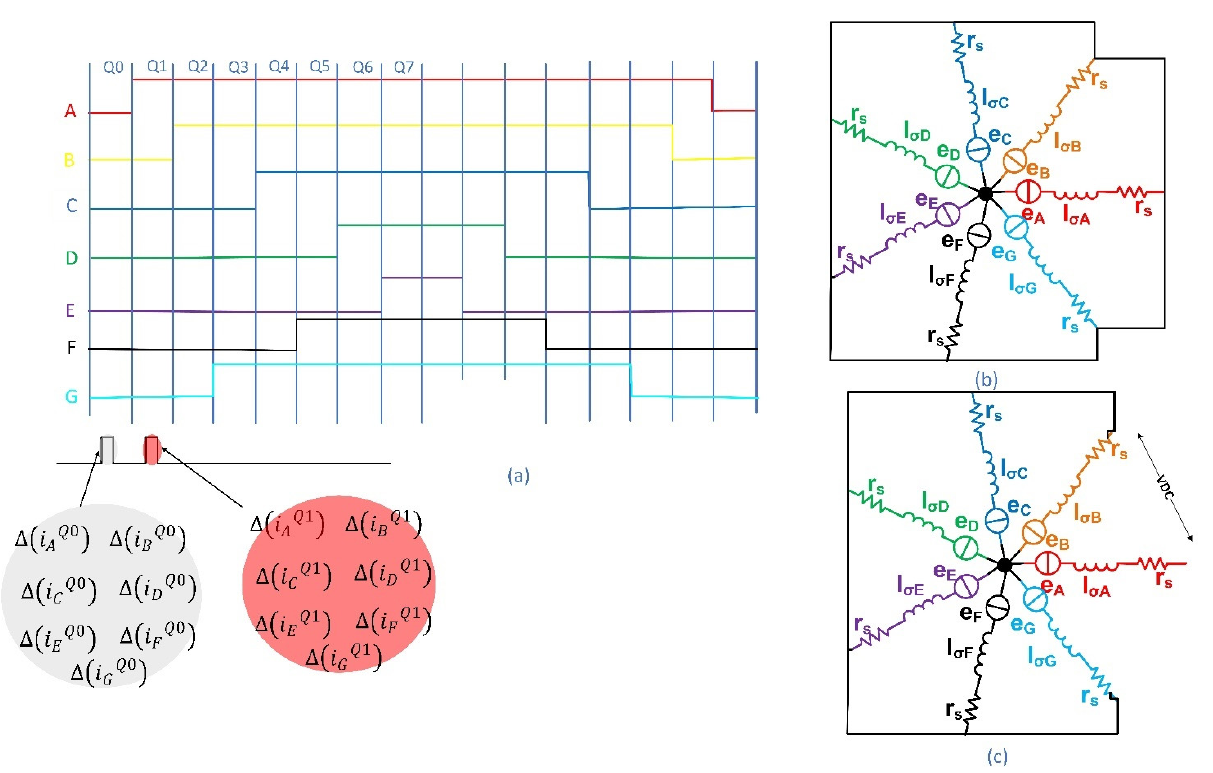
Figure 7. ( a ) Sampling instants of the current response when the vectors Q1 and Q0 are used to track the saliency, ( b ) dynamic circuit when Q0 is applied, and ( c ) dynamic circuit when Q1 is applied.